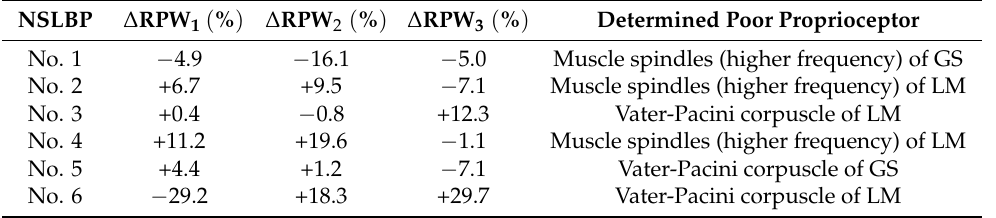
Table 4. Results of ∆ RPW i of each patient with NSLBP and determined poor proprioceptors.